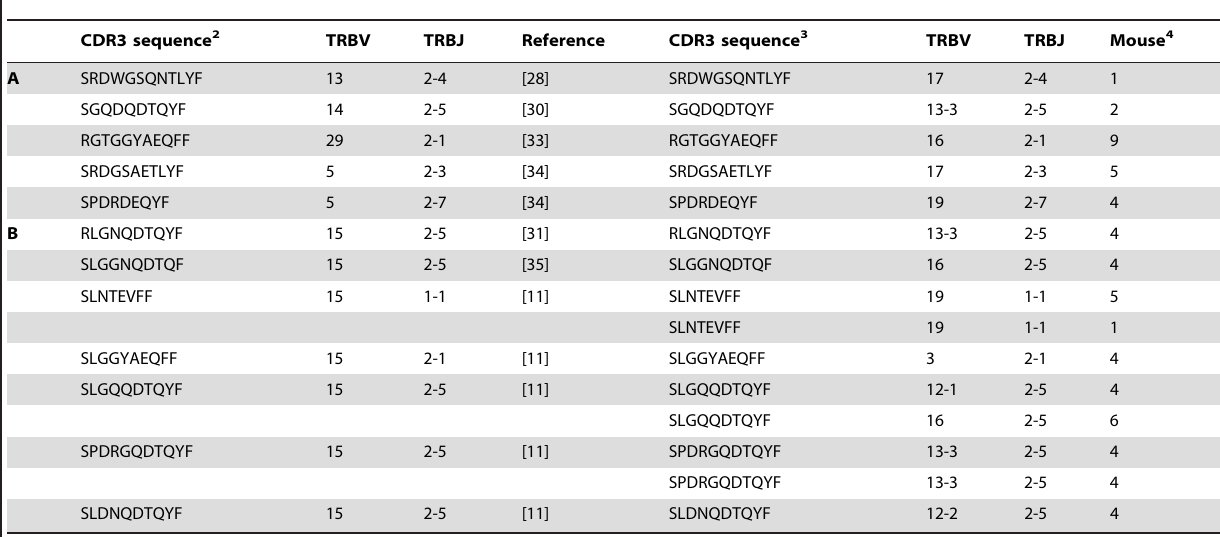
Table 5. Comparison of CDR3 b sequences from CD4 + CD44 high T cells and published sequences differing in TRBV usage 1 .